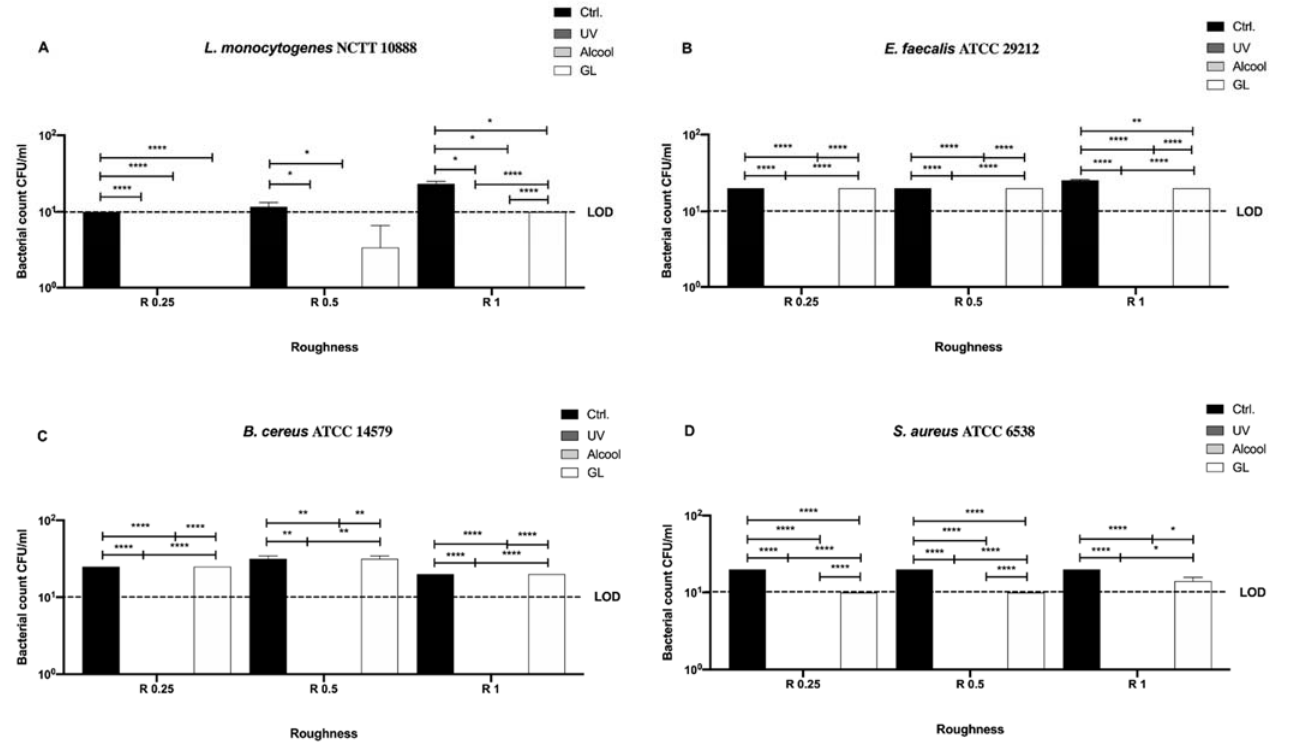
Figure 9. Graphical representation of the antibacterial activity of UV, alcohol 70% v/v and GL against Gram-positive bacteria ( A – D ) at different AISI 316 stainless steel surface roughness coated with nanoXHAM ® D, **** p < 0.0001, ** p < 0.01, * p < 0.05; Limit of detection (LOD) is 10 1 (10E+1).